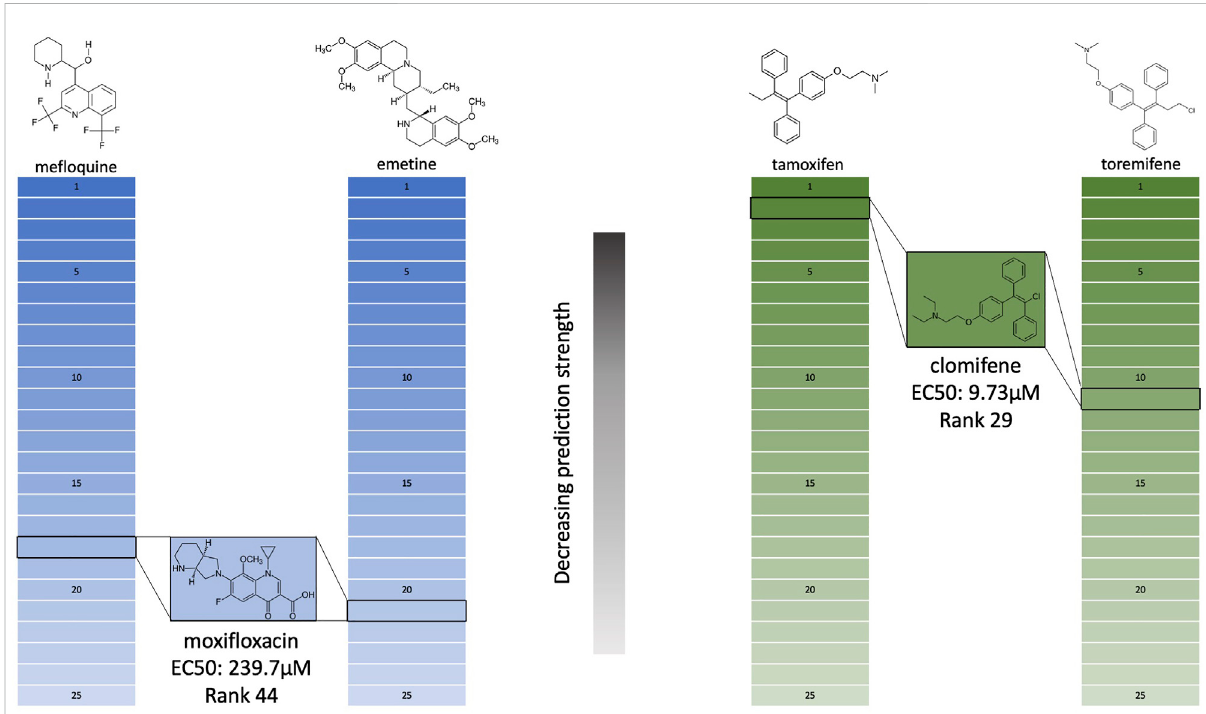
FIGURE 5 Analysis of the ef fi cacy of two SARS-CoV-2 inhibitors with respect to proteomic interaction signature similarities predicted using the CANDO platform. The structures of two validated compounds from the 3.5.20 similarity list, moxi fl oxacin (blue) and clomifene (green), are shown with EC50 values of239.7 and 9.73 μ M, respectively. The EC50values arebased on thefullvirus invitro inhibition ofSARS-CoV-2.Their ranks inthelist of thetop25mostsimilarcompoundstotwodifferentcoronavirusactivesareoutlinedinblack;moxi fl oxacinisatrank18and21incomparisonto me fl oquine and emetine, and clomifene is at rank 2 and 11 in comparison to tamoxifen and toremifene, respectively. These ranks are determined by thesimilaritycoef fi cient(Sorenson-Dice) oftheproteomicinteractionsignaturesbetweenthequerycompoundandall othersintheCANDO library. The proteomic signatures are vectors of interaction scores between a compound and a library of 5,317 human proteins computed using our in- house docking protocol BANDOCK (see Section 3.3). The fundamental hypothesis underlying the CANDO platform is that similar drugs will have similar behavior in biological systems as measured by their proteomic interaction signatures. Despite the relatively high rank (44) of moxi fl oxacin in the 3.5.20 similarity list, its measured EC50 was poor; this is explained by its lower interaction signature similarity to the two coronavirus actives depicted suggesting behavioral signal strength inversely correlates with rank. On the other hand, clomifene, the next highest prediction from the 3.5.20similaritylistatrank29,hasastrongerEC50andrankshigherinthesimilarityliststotwocoronavirusactivecompounds.Howeverthereported EC50 values of me fl oquine and emetine are strong at 4 – 15 and 0.46 μ M, respectively, which implies that behavioral similarity signal is preserved for highly ranked compounds and that using lower rank cutoff thresholds produces stronger